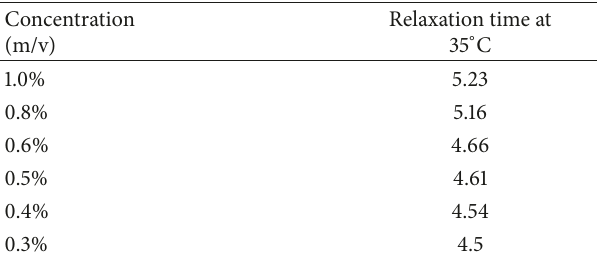
Table 7: Relaxation time ( × 10 −12 s) at different concentration at 1MHz for polyvinyl alcohol